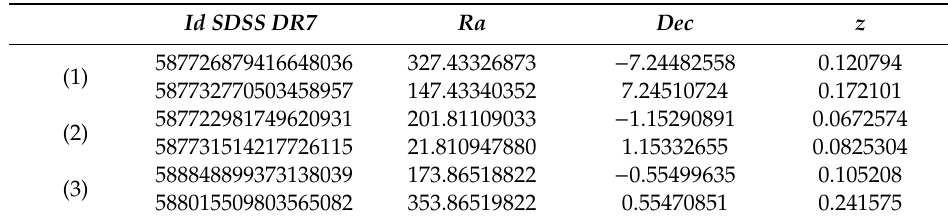
Table 3. Pairs of opposite galaxies for the e ff ect of cosmic mirror [36]—alternative approach. Id SDSS DR7 is objID identification number in the Sloan Digital Sky Survey. Accuracy is of 0.0005 ◦ for ra and dec and z / 2 for z .